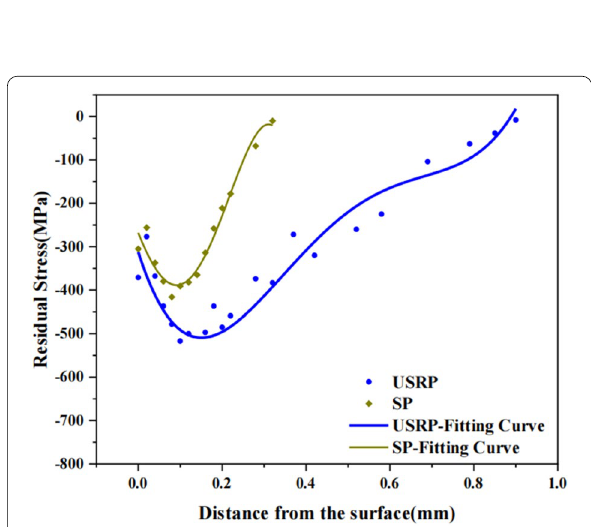
Figure 14 The residual compressive stress distribution of the AsR, SP and USRP